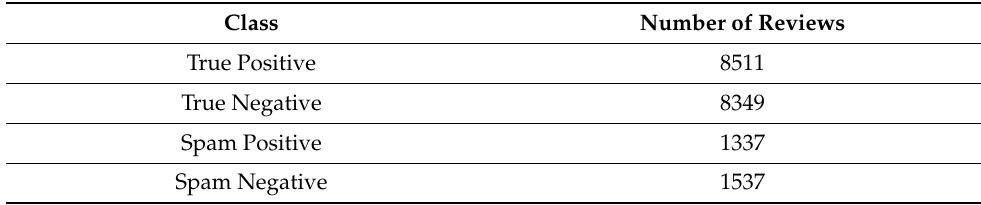
Table 4. Distribution of Douban Movie Review Dataset.